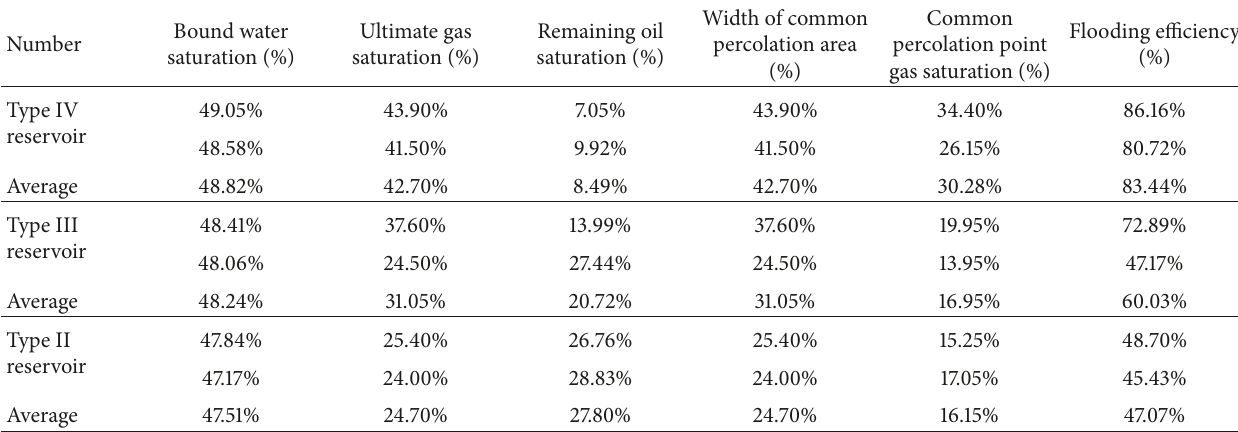
Figure 5: Curves of oil and water phase-permeability in three types of reservoirs and photos of residual oil. Table 3: Oil and gas phase-permeability test data of three types of